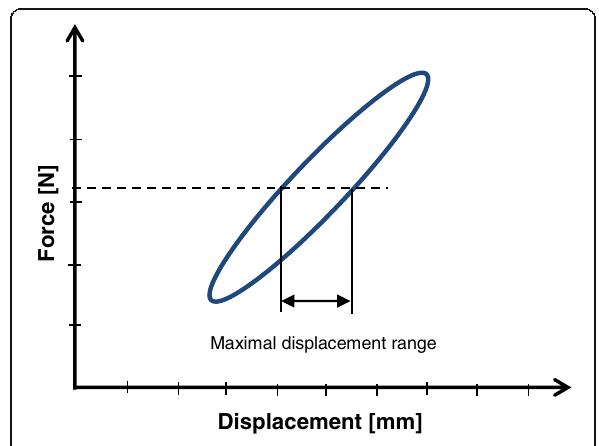
Fig. 2 Maximal displacement range within a hysteresis loop of an ideal spring-damper element: The hysteresis loop of an ideal spring-damper element is an inclined